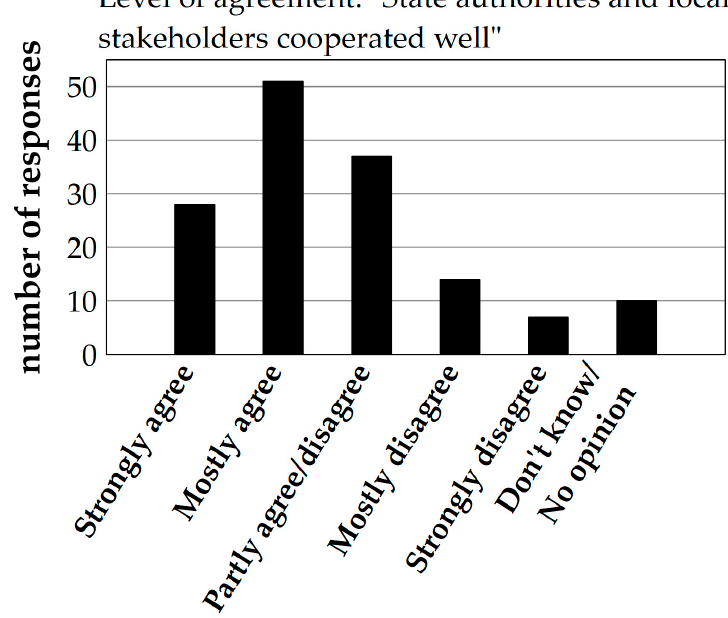
Figure 9. Cooperation of state authorities and local stakeholders.